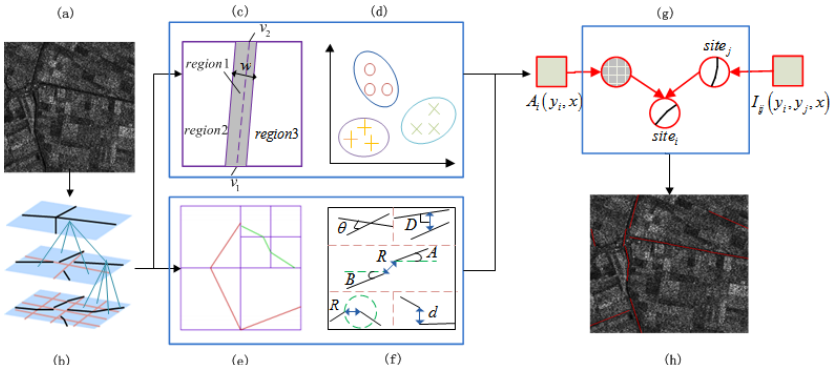
Figure 1. Flowchart for the multi-scale Bayesian framework. ( a ) Input image; ( b ) multi-scale pyramid; ( c ) multi-scale linear feature detector (MLFD) framework; ( d ) likelihood in unary potential; ( e ) beamlet analysis; ( f ) prior constraints in the pairwise potential; ( g ) conditional random field (CRF) model; and ( h ) road